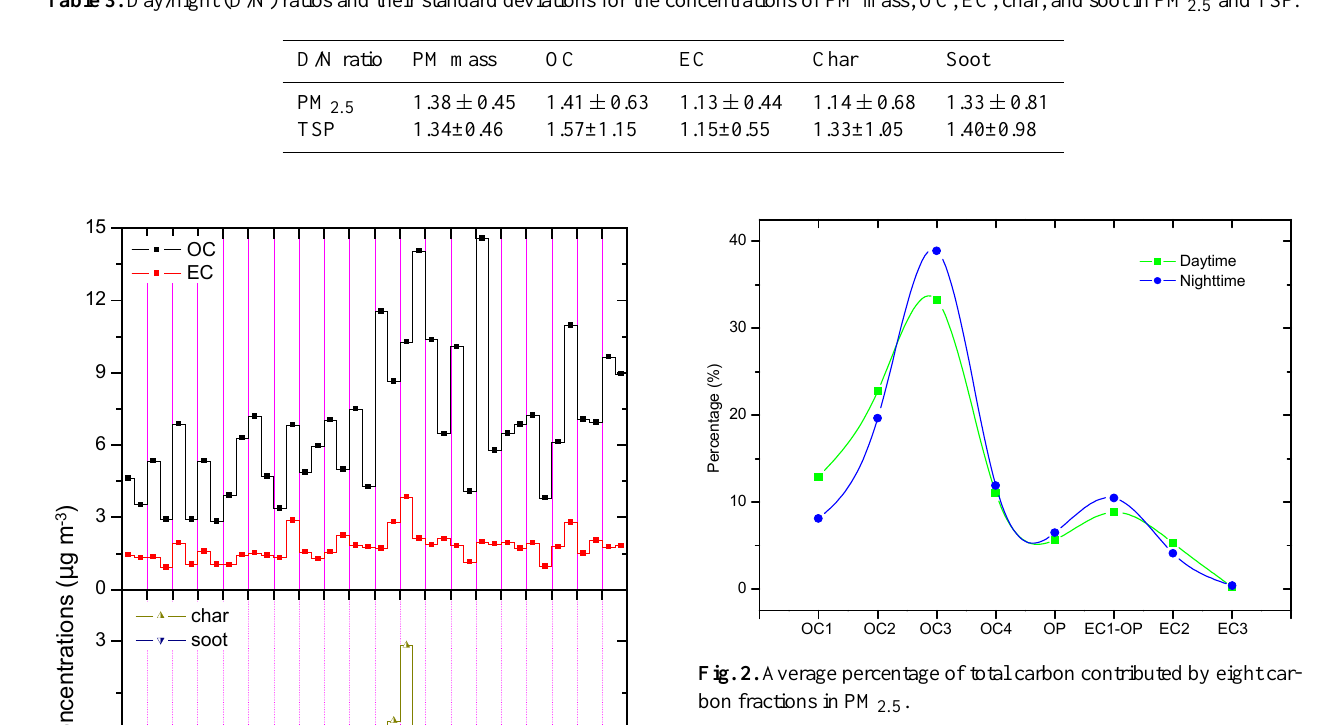
Table 3. Day/night (D/N) ratios and their standard deviations for the concentrations of PM mass, OC, EC, char, and soot in PM 2 . 5 and TSP.